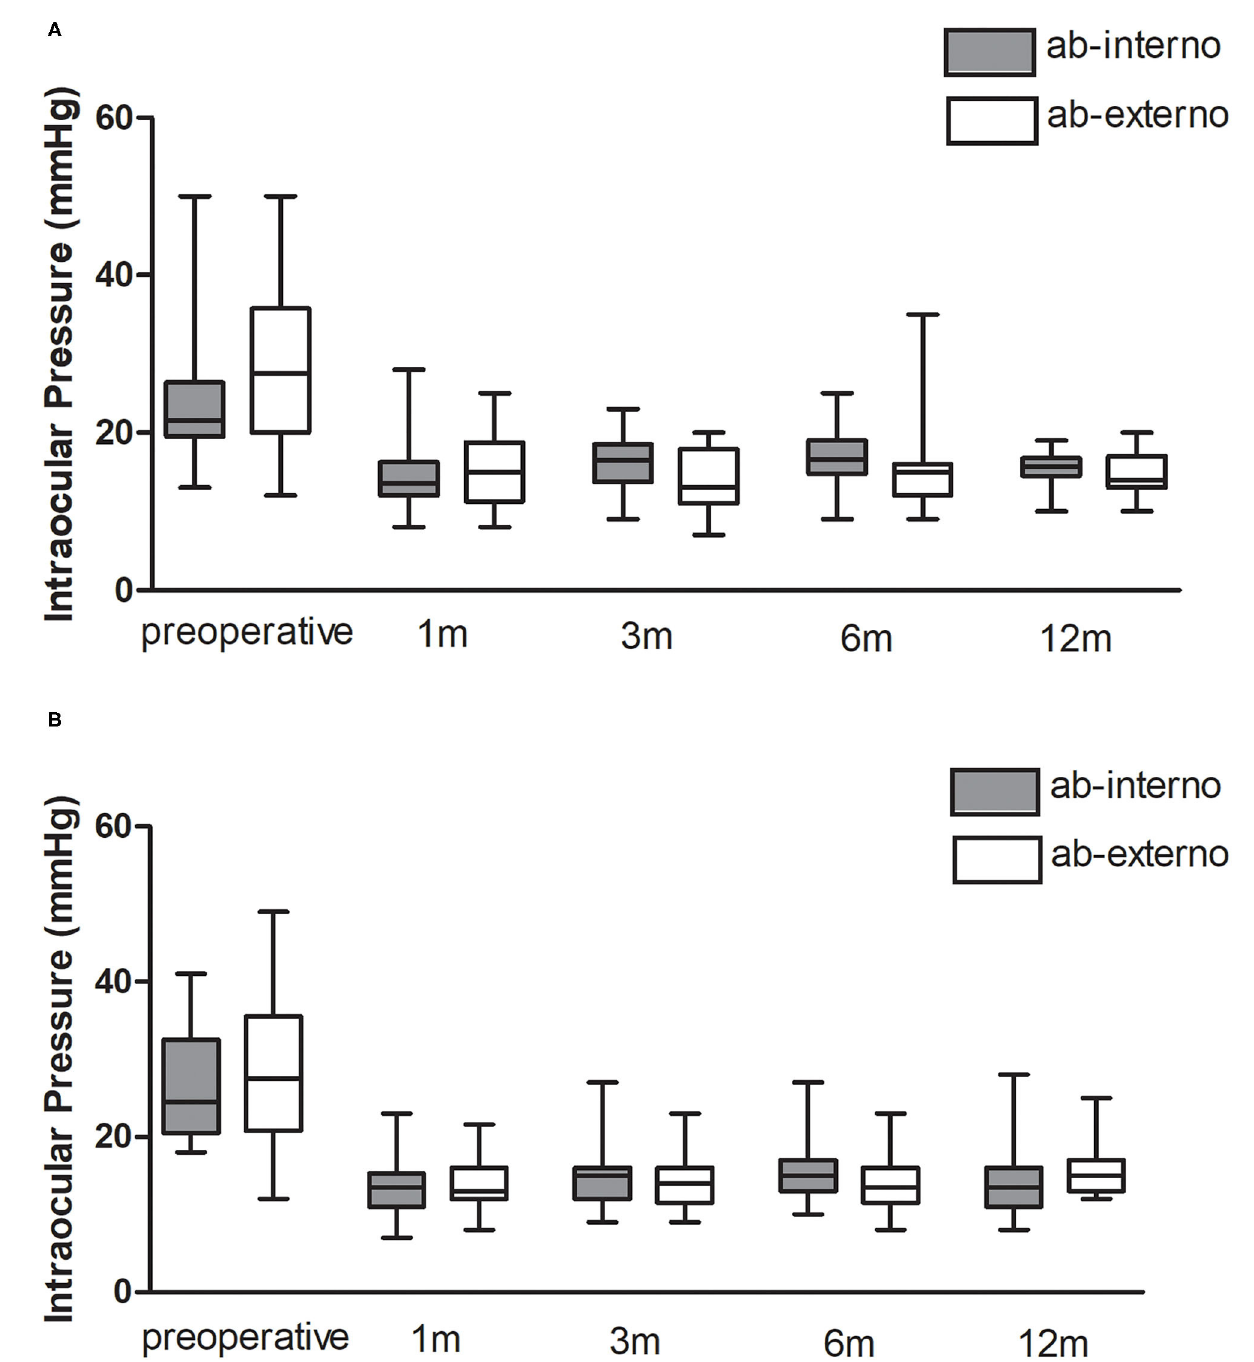
FIGURE 2 | IOP comparison according to surgical approach. (A) patients without prior glaucoma surgery; (B) patients with prior glaucoma surgery.